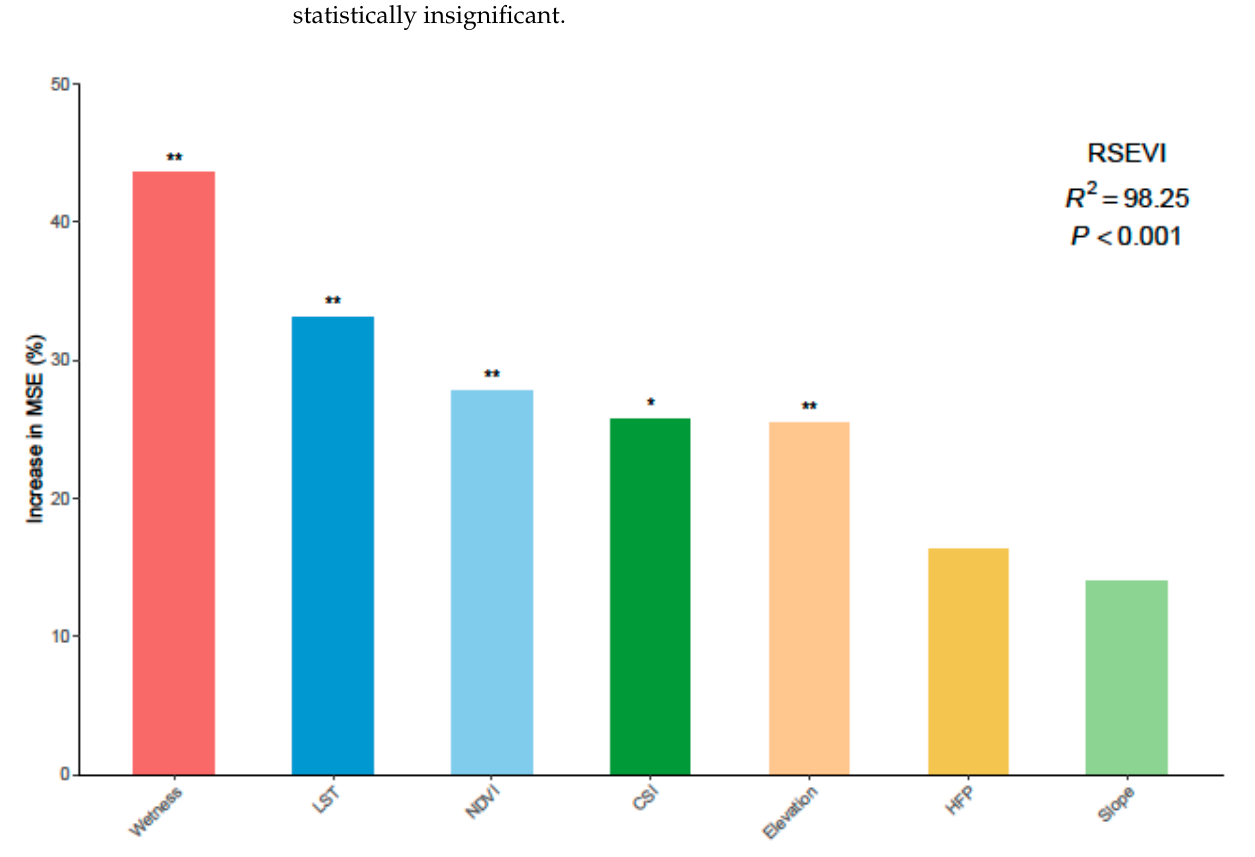
Figure 5. The importance scores of the driving factors affecting the remote sensing ecological vulnerability index (RSEVI) on the Qinghai-Tibet Plateau. Significance levels are as follows: * p < 0.05, ** p < 0.01. MSE, mean squared